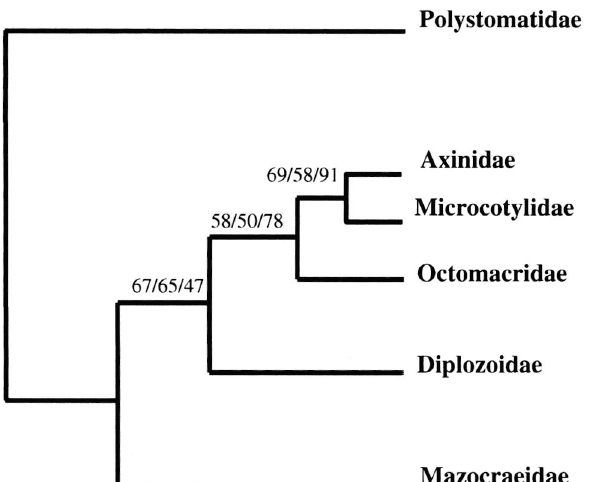
Fig. 1. - Molecular Phylogenetic relationship between Diplozoidae, Octomacridae and other teleost's Polyopisthocotylea inferred from partial 18S rDNA sequences and partial 28S rDNA sequences. We have compiled the 18S rDNA and the 28S rDNA sequences in the same phylogenetic analysis and we obtained a most strongly sup­ ported topology than the separate analysis. Numbers on branching are the bootstrap proportion calculated with 500 iterations respec­ tively with bio neighbour-joining method, MP and ML. The likeli­ hood for other imposed topology was tested with Phylowin and this tree still the best one. The relative rate of evolution of internal branches was estimated with RRTree to detect a potential "long- branch" effect. Only the Mazocraeidae show a significantly faster evo­ lutionary rate compared to the other Polyopisthocotyleans using Neo- polystoma as